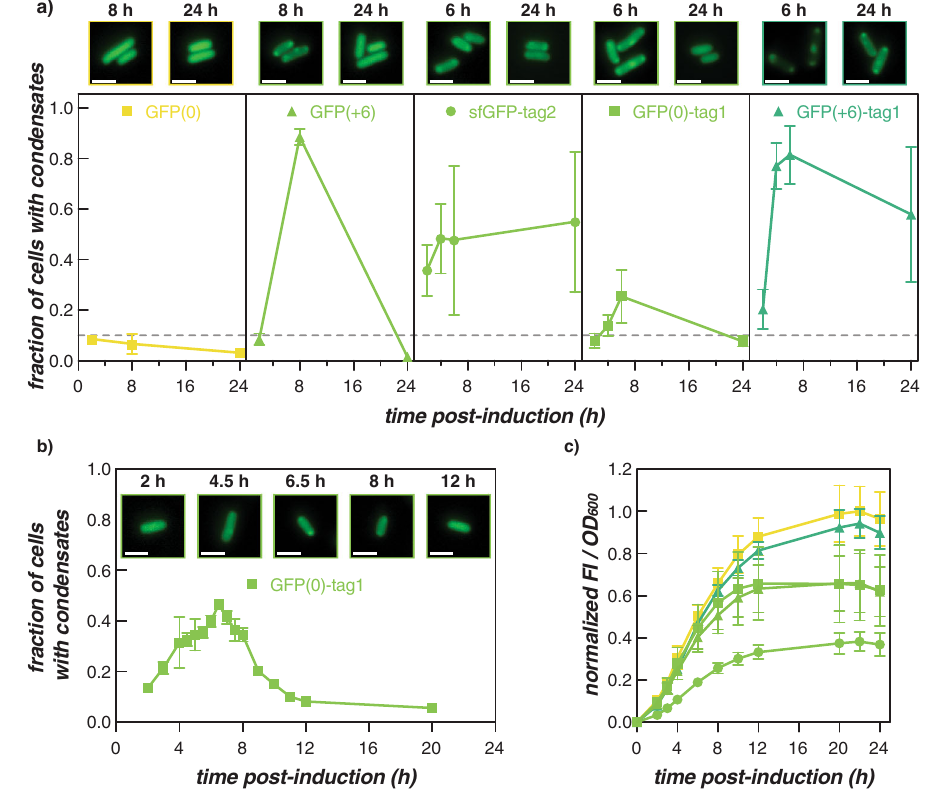
Fig. 3 | Changing GFP concentration allows for reversible intracellular phase separation. a The fraction of cells with condensates was monitored over time for select GFP variants. Interestingly, GFP(+6) and GFP(0)-tag1 form condensates at 6 – 8h, but not at earlier or later time points, suggesting that intracellular phase separation of supercationic GFP is reversible. b Condensate formation and dis- assembly in cells expressing GFP(0)-tag1 monitored for 20h after induction. The maximum fraction of cells with condensates was observed at 6.5h post-induction, after which condensates fully disassembled at 12h. Representative microscopy imagesofcellsattheindicatedtimepost-inductionareprovided(in a and b ).Scale